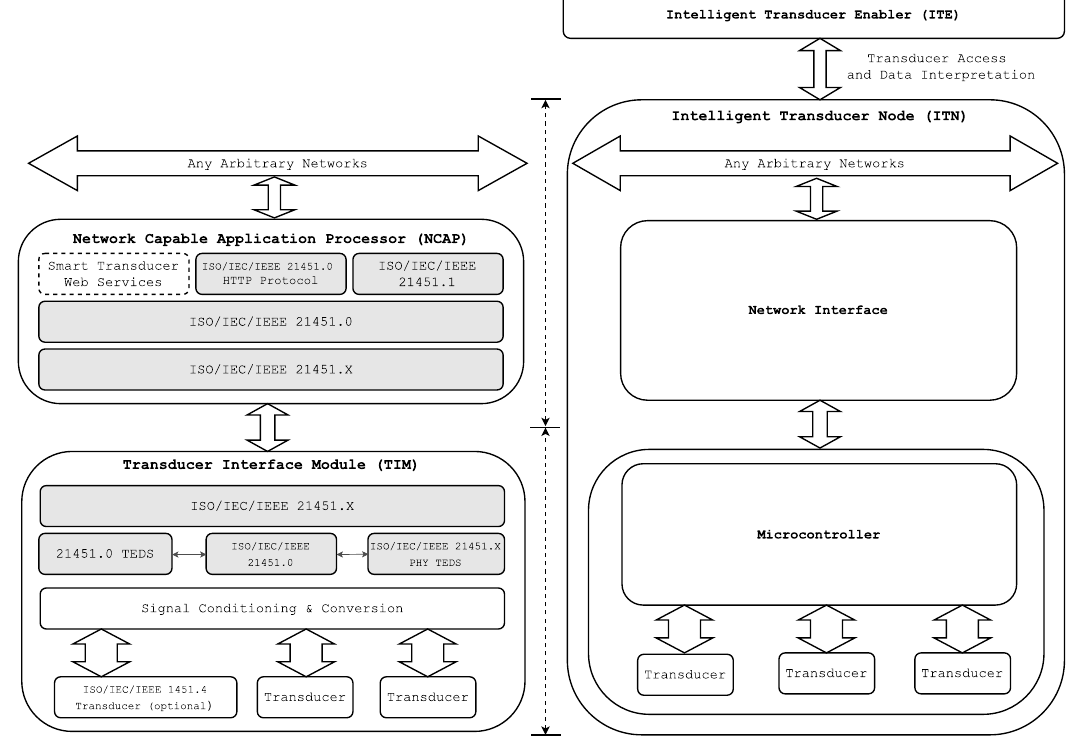
Figure 7. Comparison of ISO/IEC/IEEE 21451 and HASITE